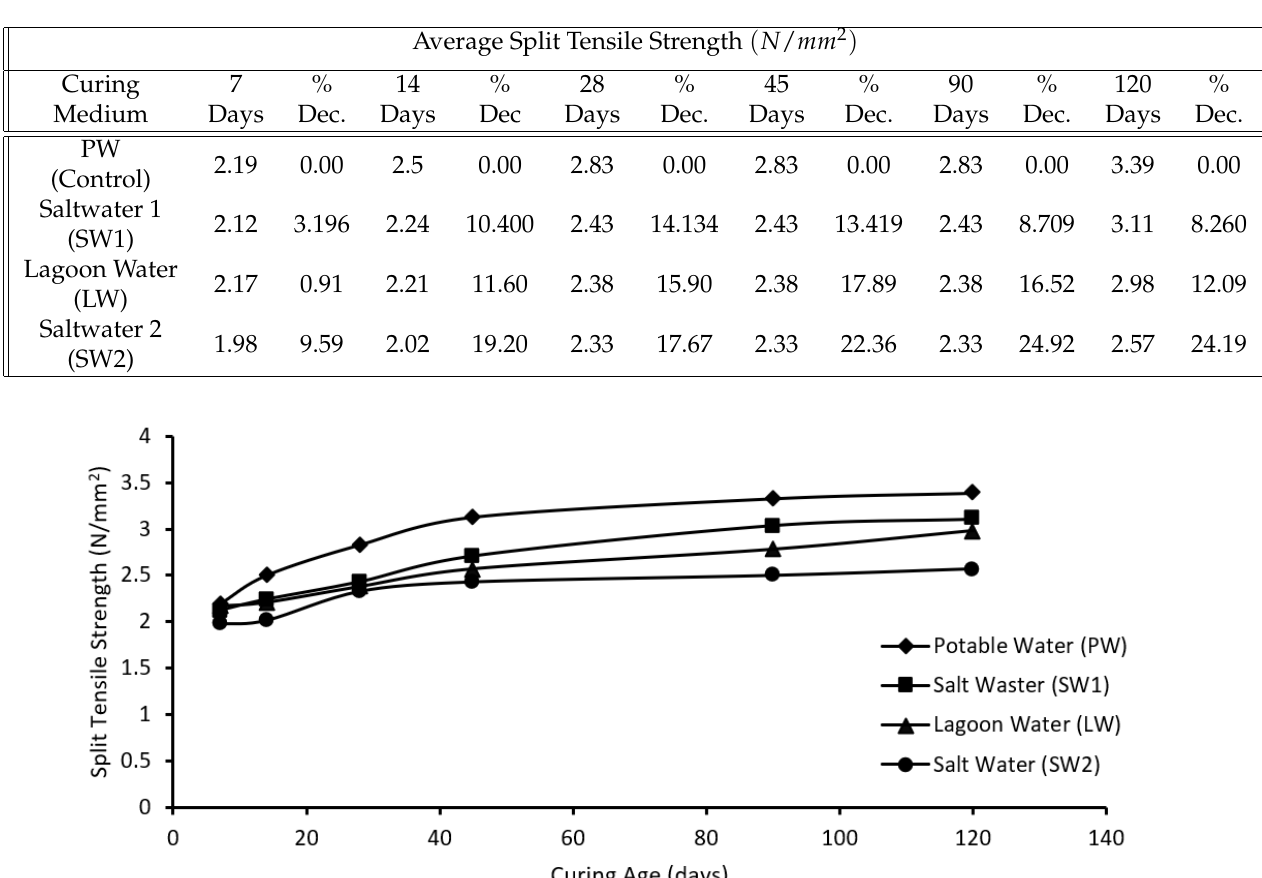
Table 4. Effect of different curing medium on split tensile strength of concrete